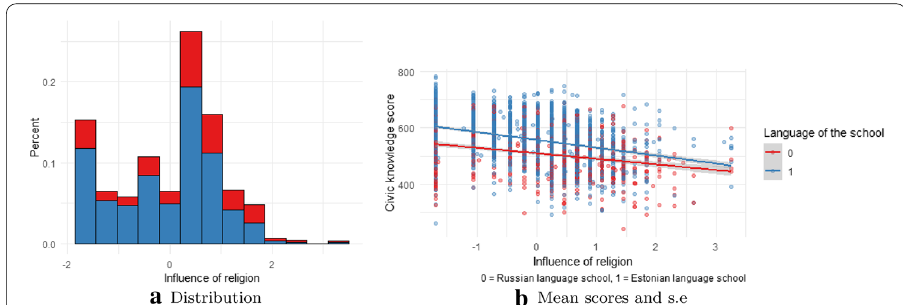
Fig. 4 Influence of the religion in the society